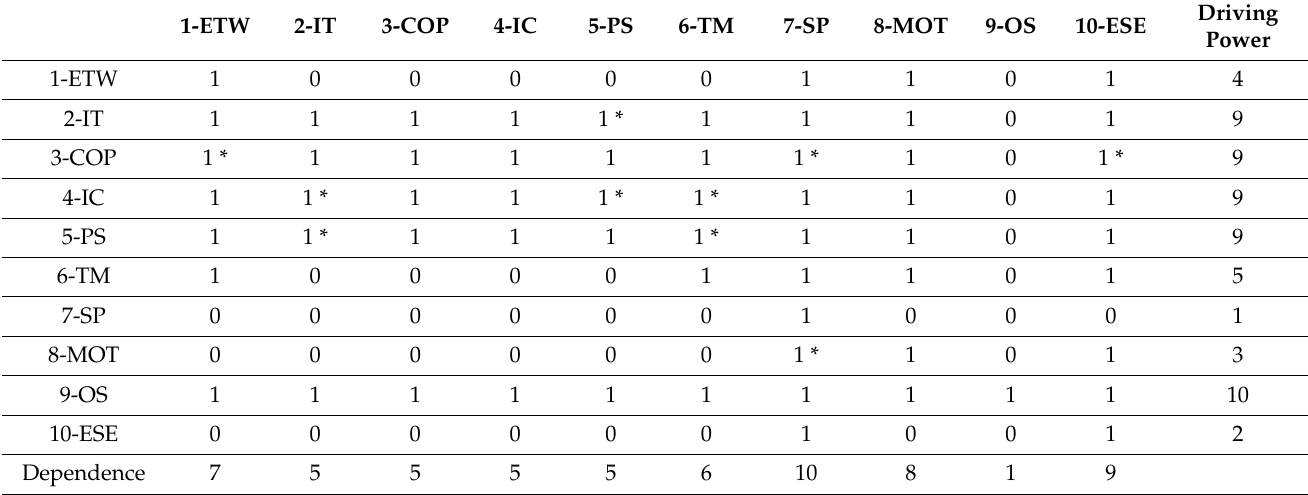
Table 4. Calculation of driving power and dependence power of SSIM.